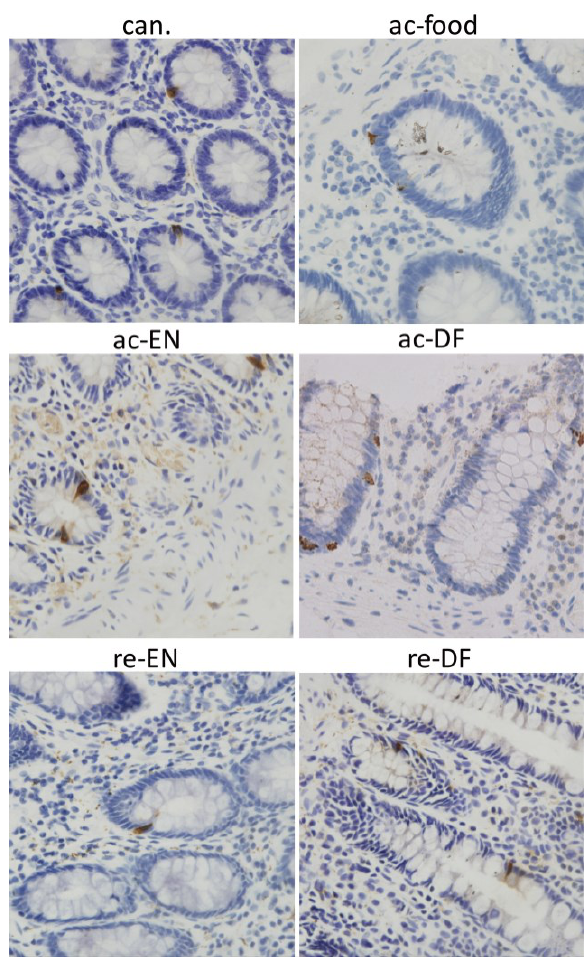
Figure 7. Expression of peptide-YY in crypt and lamina propria. For all these